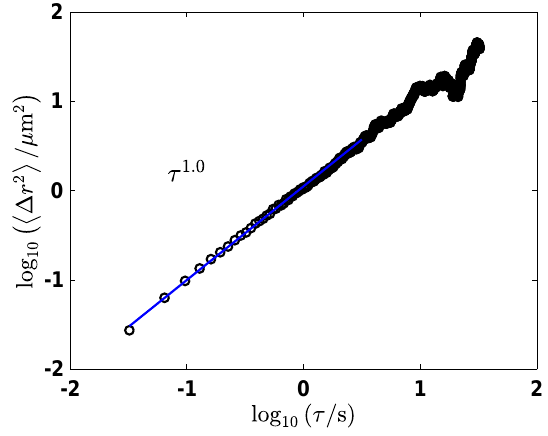
Figure 5: MSD of particles that were suspended in ASM. The MSD scales as t 1 , and the viscosity was measured to be 1.6 × 10 −3 Pa ·